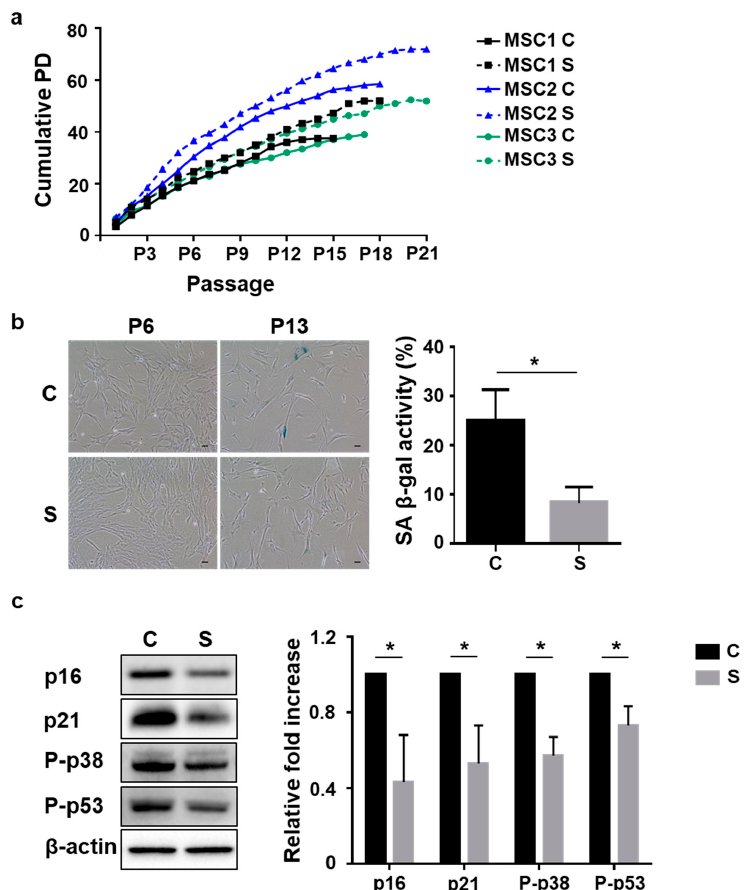
Figure 1. Small-sized cells from umbilical cord blood-derived mesenchymal stem cells (UCB-MSCs) exhibit delayed cellular senescence compared to heterogeneous cells during in vitro expansion. Three lots of UCB-MSCs separated by cell size isolation were cultured until cell growth stopped. (C: control or heterogenous cells, S: small-size cells); ( a ) the cumulative population doubling (PD) values were monitored until growth ceased; ( b ) the senescence activity was measured and quantified using senescence-associated beta-galactosidase (SA β -gal) staining at P6 and P13. SA β -gal staining revealed almost no positive cells in both groups at P6. Staining level increased considerably in MSCs in both groups from P6 to P13. Scale bars = 10 µ m (left panel). SA β -gal activity was significantly lower in small cells compared to heterogenous cells at P13 (right panel); ( c ) expression levels of senescence-related proteins were analyzed at P13 using immunoblotting (left panel). The levels were normalized to those of ß-actin, with the expression level in control cells defined as 1 (right panel); ( b , c ) data are presented as mean ± standard deviation (SD), n = 3 per group. * p < 0.05. C, control cells; S, small cells; PD, population doubling; P, passage; SA ß-gal staining, senescence-associated beta-galactosidase staining; P-p53, phosphorylated p53; P-p38, phosphorylated